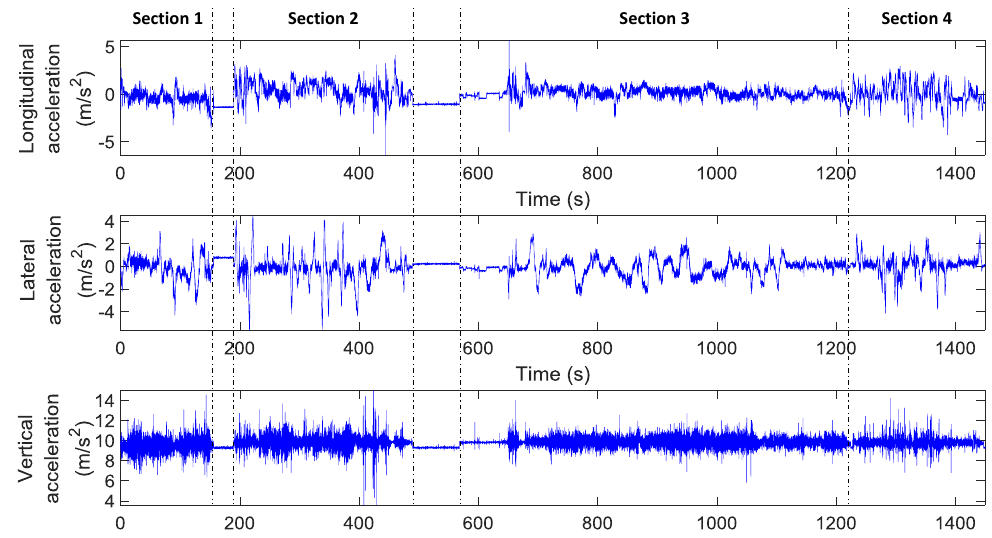
Figure 3. Longitudinal, lateral and vertical acceleration experienced by the passenger across the representative